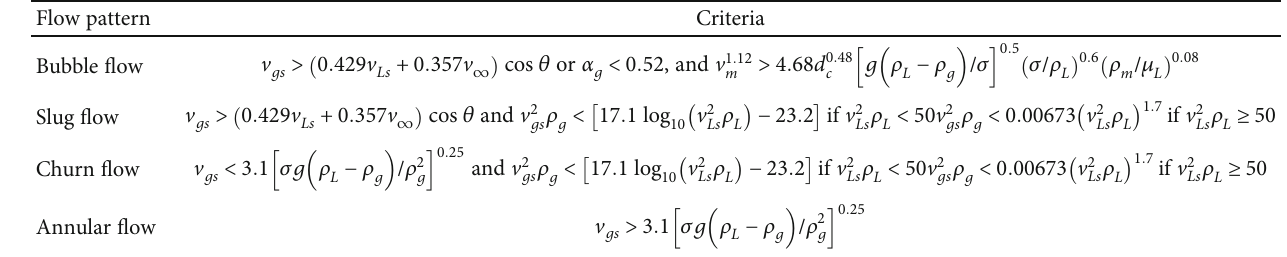
Table 1: Criteria of gas/liquid fl ow pattern transition.